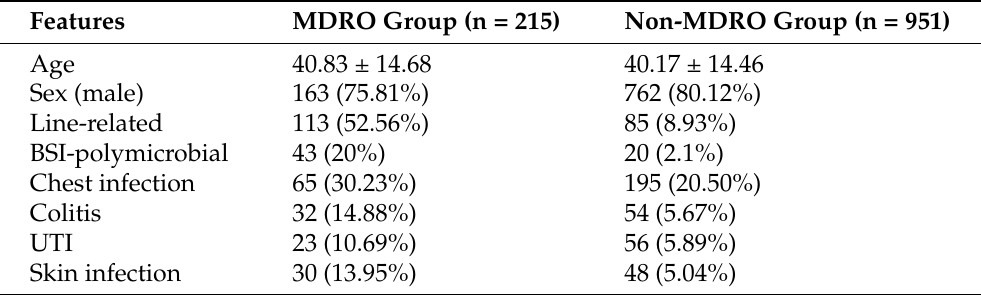
Table 3. Distribution of features in the MDRO and non-MDRO groups, number of FNEs, n = 1166. Along with the features listed below, other multi-category features, such as region of origin, diagnostic category, treatment phase, disease status, and type of microorganism in the bloodstream, were used to predict MDRO. A total of 13 variables were used in the model to predict MDRO.